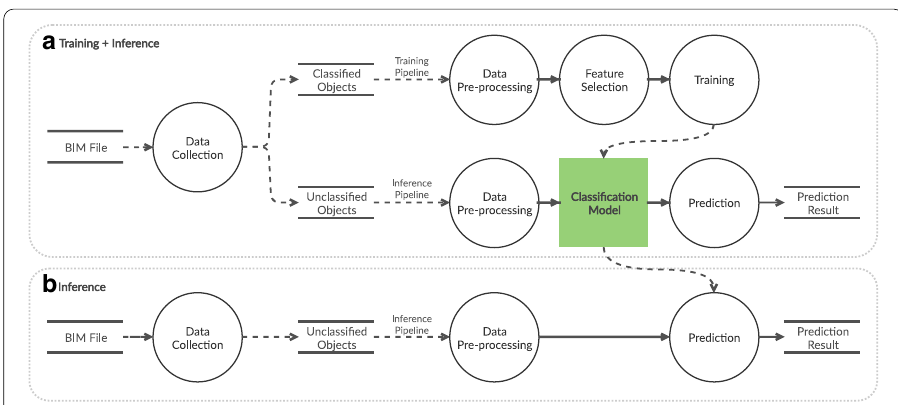
Fig. 2 Activities in Machine Learning‑based BIM element